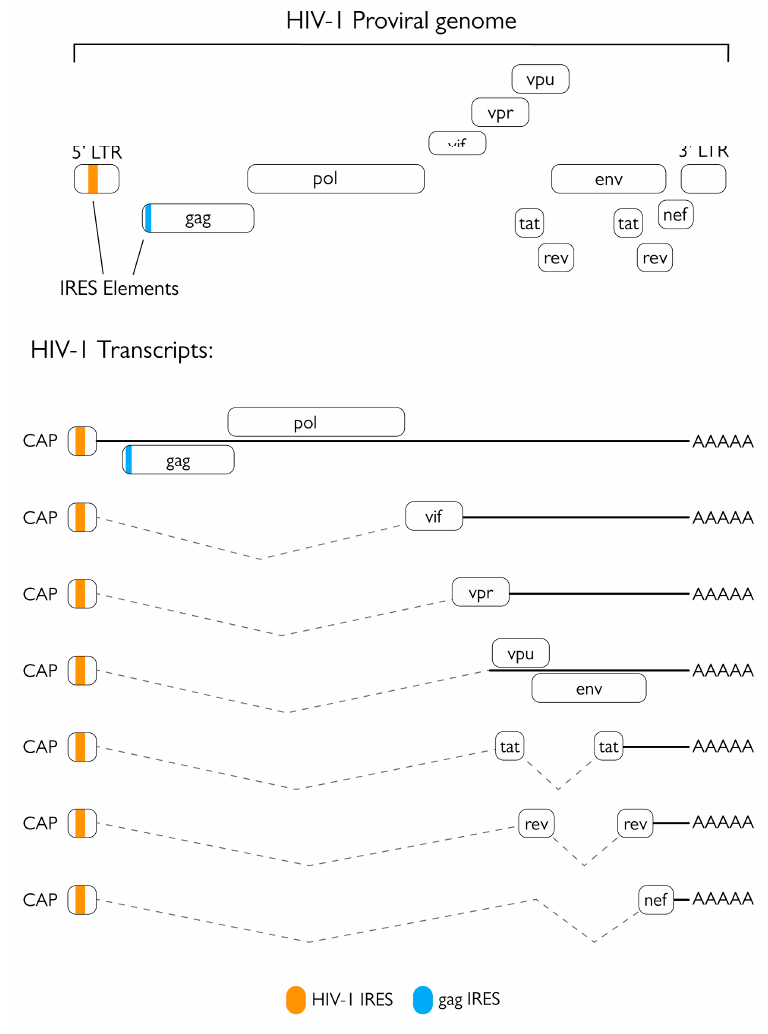
Figure 1. Schematic representation of IRES locations in the HIV-1 genome and transcripts. The HIV-1 replication cycle (Figure 2) starts with binding and entry into the target cell, which is mediated by interaction of viral glycoprotein gp120 trimers with virus re- ceptors (CD4) and co-receptors (CCR5 or CXCR4) on the cell surface. Such events lead to